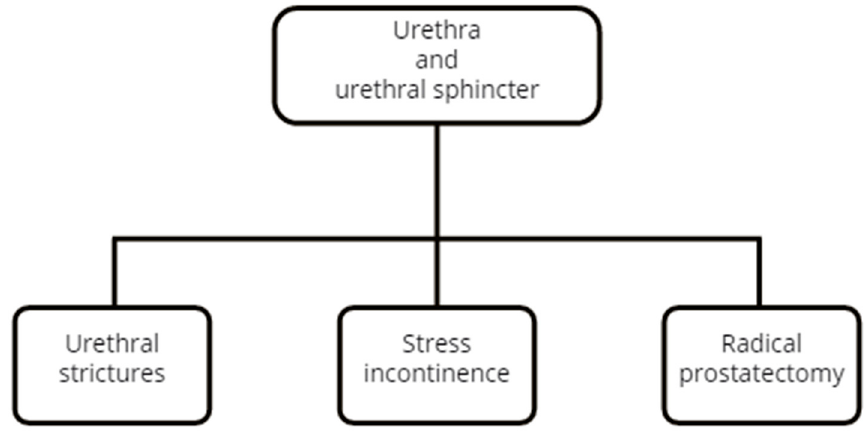
Figure 7. Pathologies of the urethra and urethral sphincter evaluated by elastography.